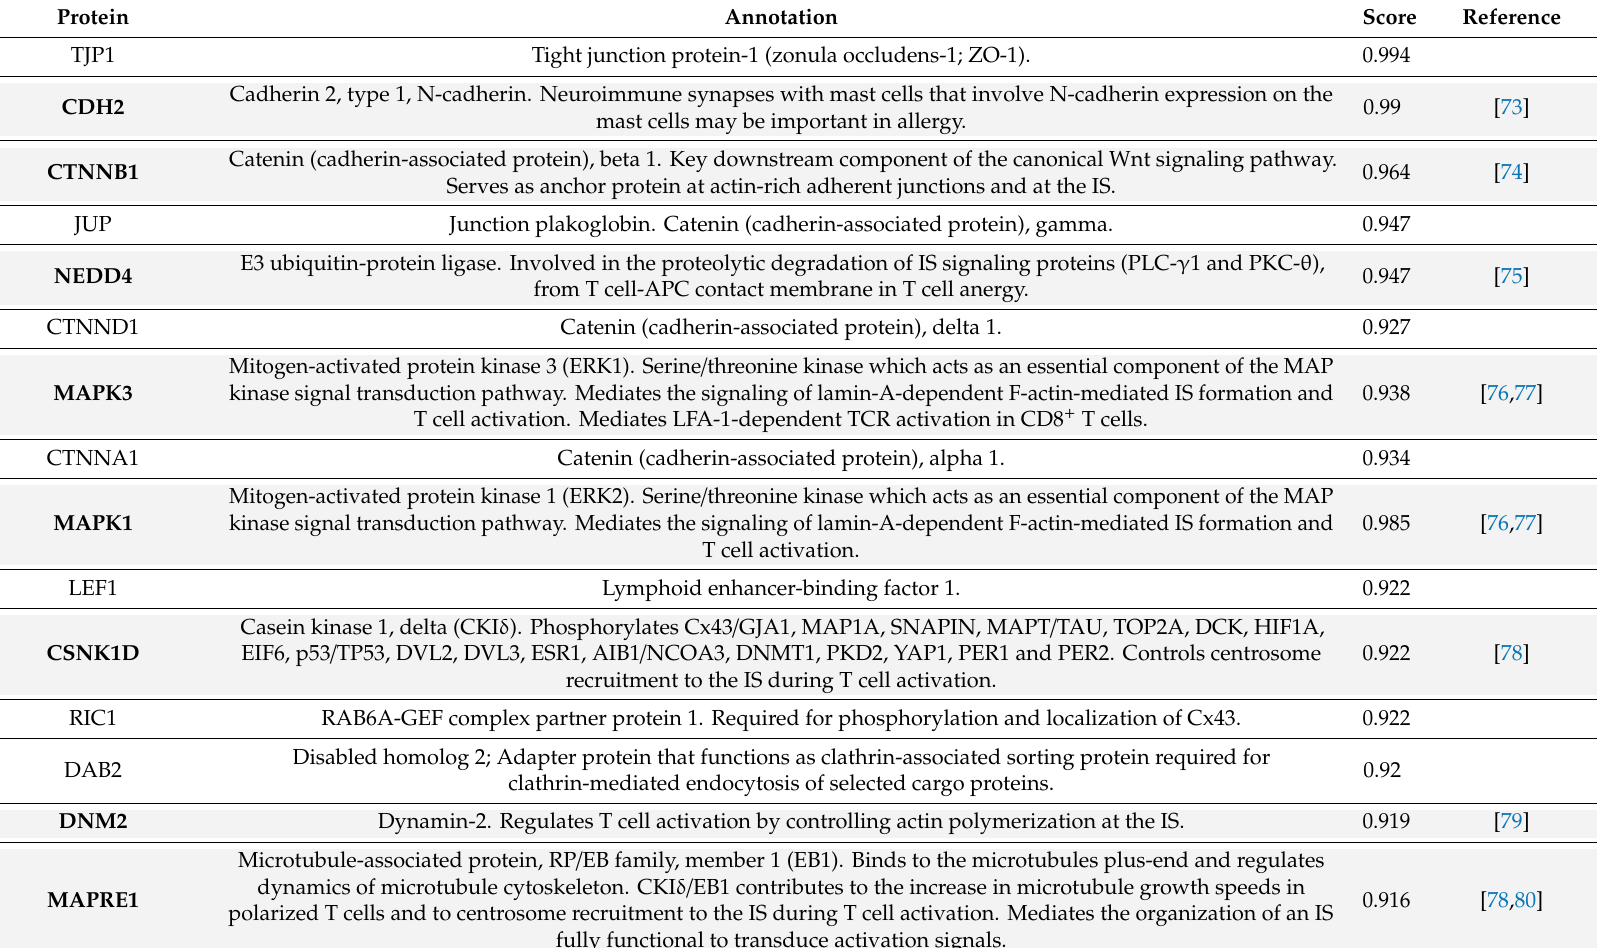
Table 1. The top-25 Cx43 protein interactome and its association with the IS. The top-25 (highest prediction setting of (scores > 0.9)) interactome for Cx43 was retrieved and constructed using the STRING database version 11.0 (http: // string-db.org). In bold letters and gray boxes are highlighted proteins that, like Cx43, translocate to and modulate the function of IS, and its associated